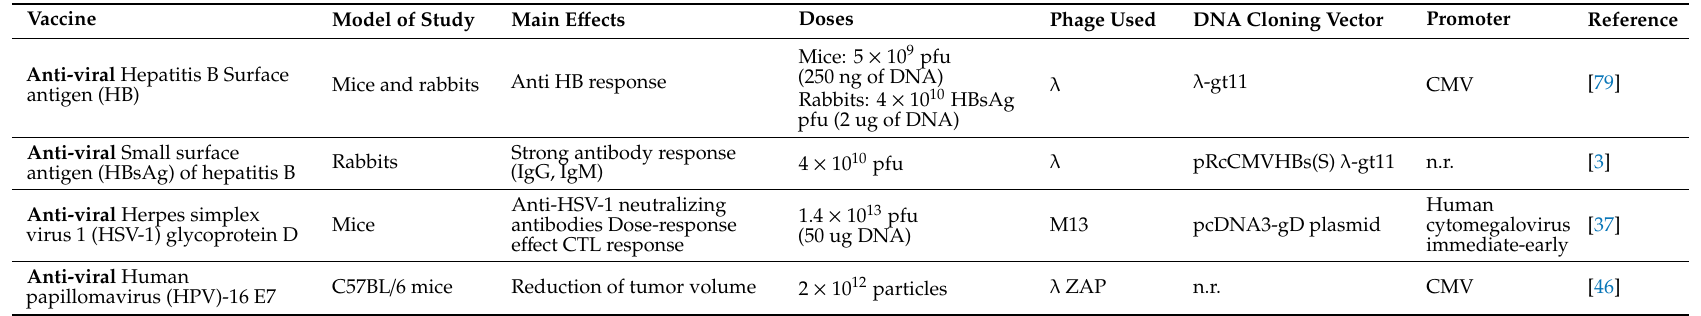
Table 4. Description of the antigen, model of study, main findings, design features and administration of antiviral bacteriophage DNA